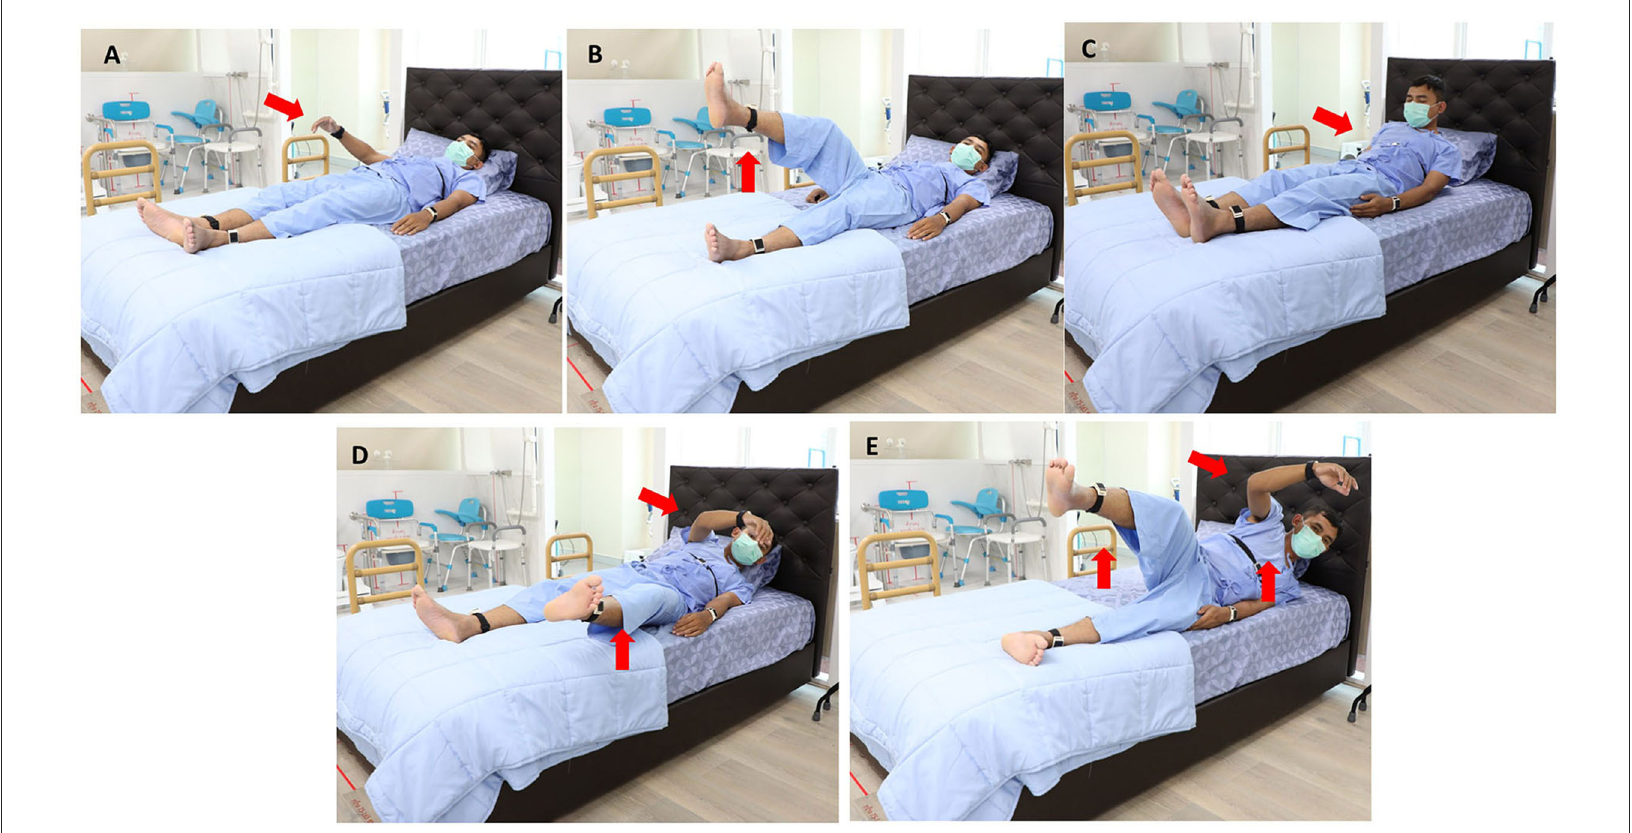
FIGURE2 Movement patterns of the supine-to-stand task were categorized according to the first body part or parts that moved. (A) Arm first; (B) leg first; (C) trunk first; (D) any arm and leg first together; (E) trunk with any arm and/or leg